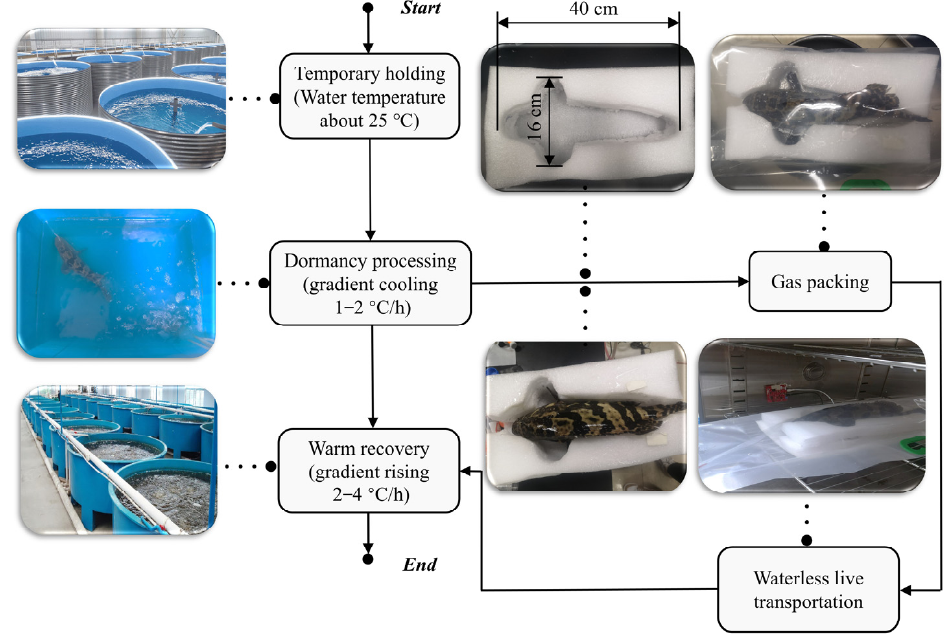
Figure 1. The whole procedure of the waterless transportation for live grouper. At present, the application of pulsed radar, Doppler radar, and frequency-modulated continuous-wave (FMCW) radar in the measurement of the respiration rate mainly focuses on the human body [13–15]. The FMCW radar, as opposed to pulse radar and Doppler radar, can detect the distance to target and Doppler information at the same time, and has become the standard in the field of breathing monitoring [16]. Higher